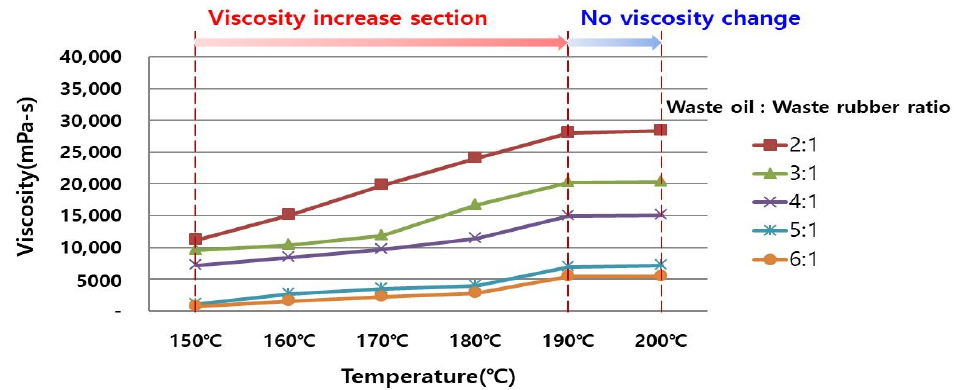
Figure 5. Variation in viscosity with melting temperature.